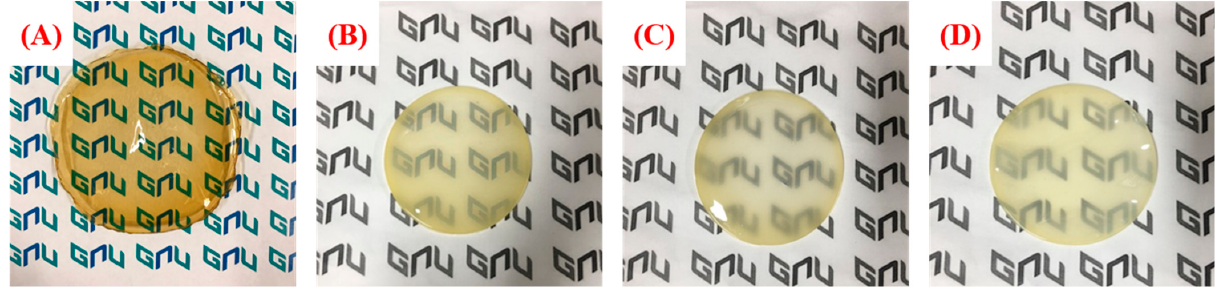
Figure 3. Pictures of blended anion exchange membranes: ( A ) pristine QA–PPO, ( B ) QA–PPO/PVDF(2/8), ( C ) QA– PPO/PVDF(3/7), and ( D ) QA–PPO/PVDF(4/6).